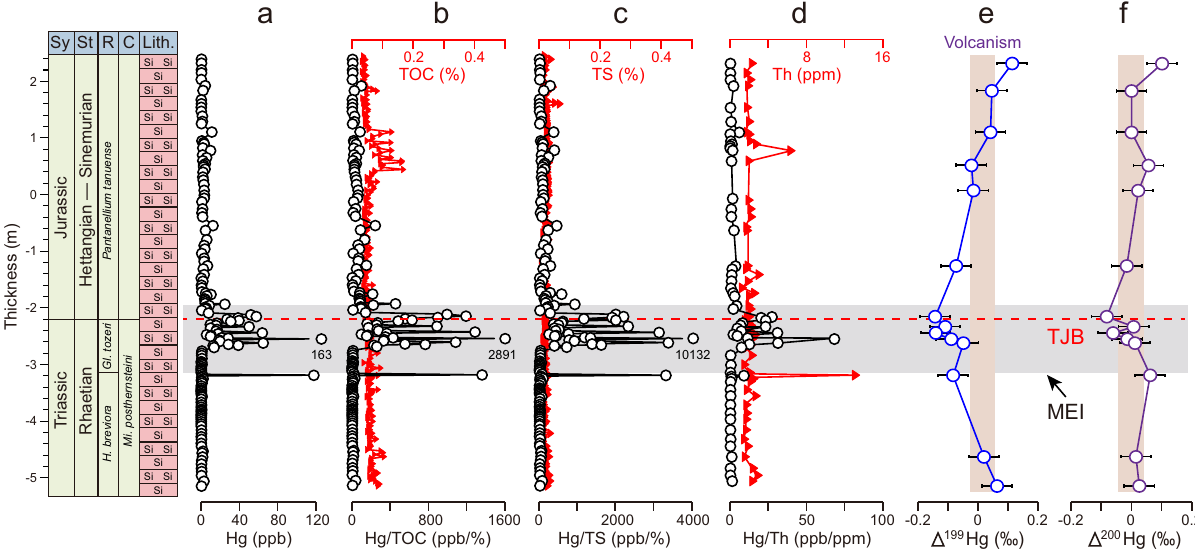
Fig. 2 Chemostratigraphy of Katsuyama. a mercury concentration (Hg, ppb); b total organic carbon (TOC, %, red triangle) and ratio of Hg to TOC (Hg/ TOC, ppb/%, open circles); c total sulfur (TS, %, red triangle) and ratio of Hg to TS (Hg/TS, ppb/%, open circles); d thorium concentration (Th, ppm, red triangle) and ratio of Hg to Th (Hg/Th, ppb/ppm, open circles); e mass-independent fractionation of odd-Hg isotopes ( Δ 199 Hg, ‰ ); and f mass- independent fractionation of even-Hg isotopes ( Δ 200 Hg, ‰ ). The gray fi eld represents the mercury-enriched interval (MEI), the vertical rectangle in e is volcanic Δ 199 Hg values ( + 0.02 ± 0.06 ‰ 71 ), and the vertical rectangle in f is Δ 200 Hg values of 0 ± 0.05 ‰ 71 . Biozonation from references 40,59 . Horizontal bars in the Δ 199 Hg and Δ 200 Hg pro fi les are standard deviation (2 σ ) values. Abbreviations: Sy = System, St = (sub)stage, R = radiolarian zone, C = conodont zone; H . = Haeckelicyrtium , Gl . = Globolaxtorum , Mi . = Misikella . Source data are provided in the Supplementary data fi